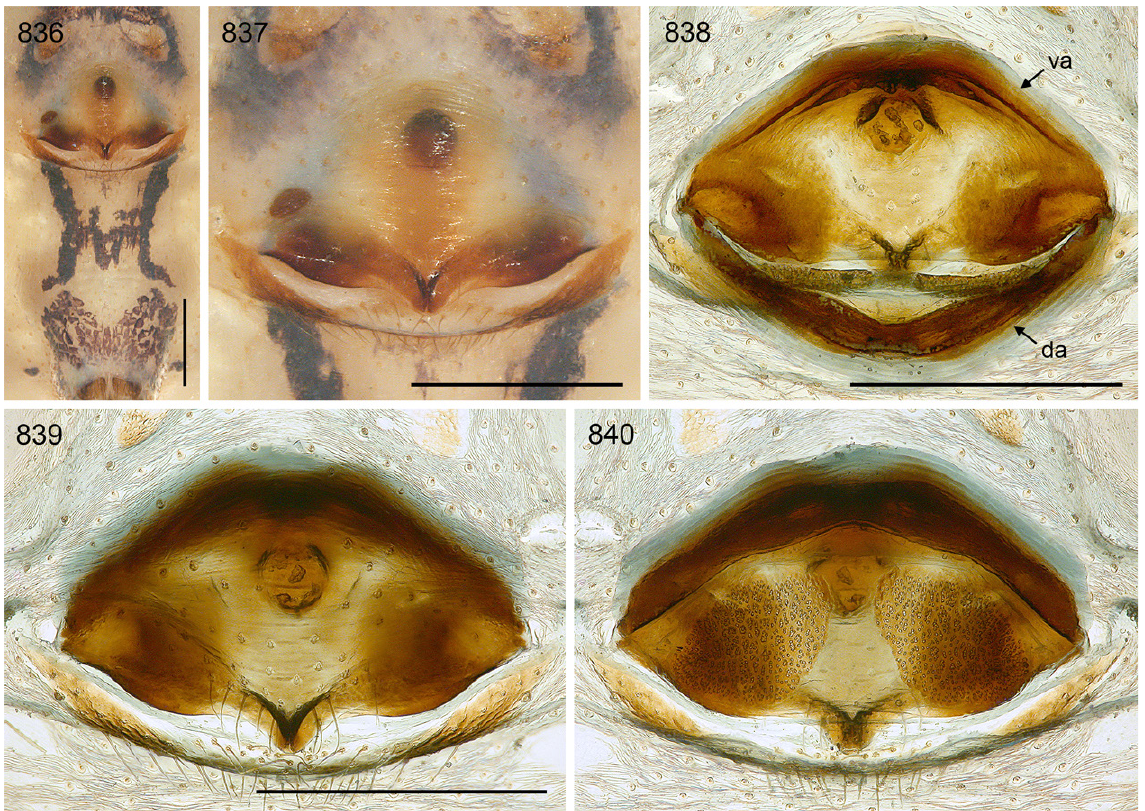
Figs 836–840. Crossopriza maculipes (Spassky, 1934); female from Uzbekistan, 6.5 km W of Akmechet (ZMMU). 836–837 . Abdomen and epigynum, ventral views. 838–840 . Cleared female genitalia, dorsal view with dorsal arc tilted backwards, ventral view, and regular dorsal view. Abbreviations: da = dorsal arc; va = ventral arc. Scale bars = 0.5